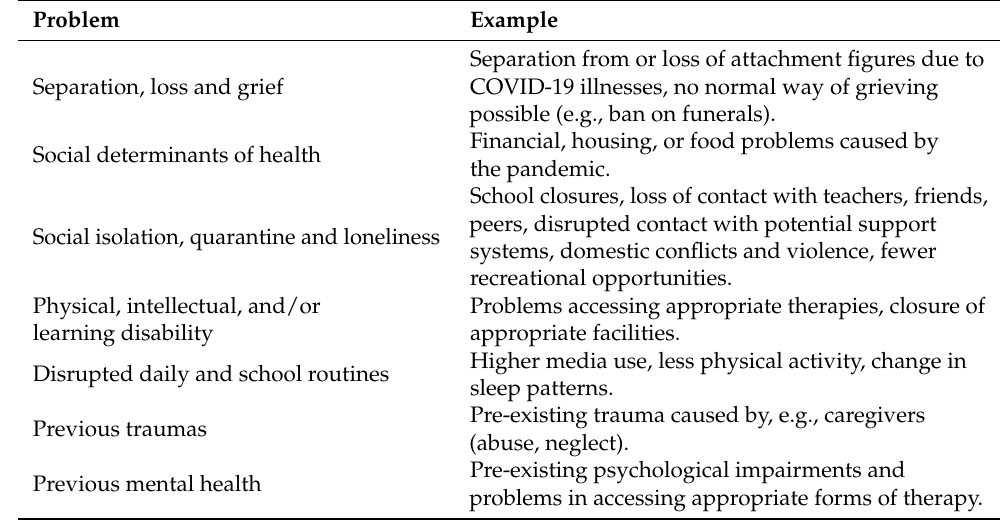
Table 1. Challenging restrictions and stress factors during the pandemic